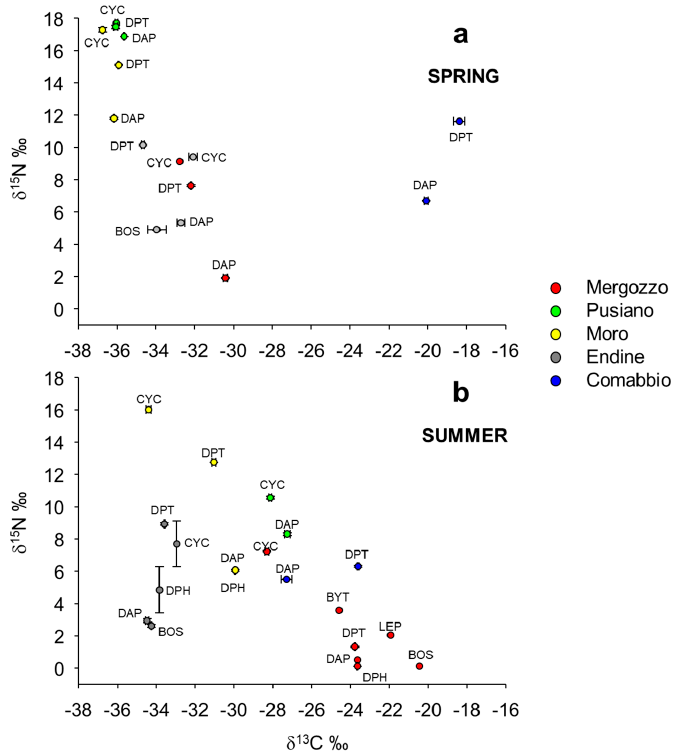
Figure 3. Trophochemical graph of zooplankton taxa signatures in spring ( a ) and summer ( b ). Error bars represent the Standard Error. CYC: cyclopoids; DPT: diaptomids; DAP: Daphnia ; BOS: Bosmina ; DPH: Diaphanosoma ; BYT: Bythotrephes ; LEP: Leptodora .